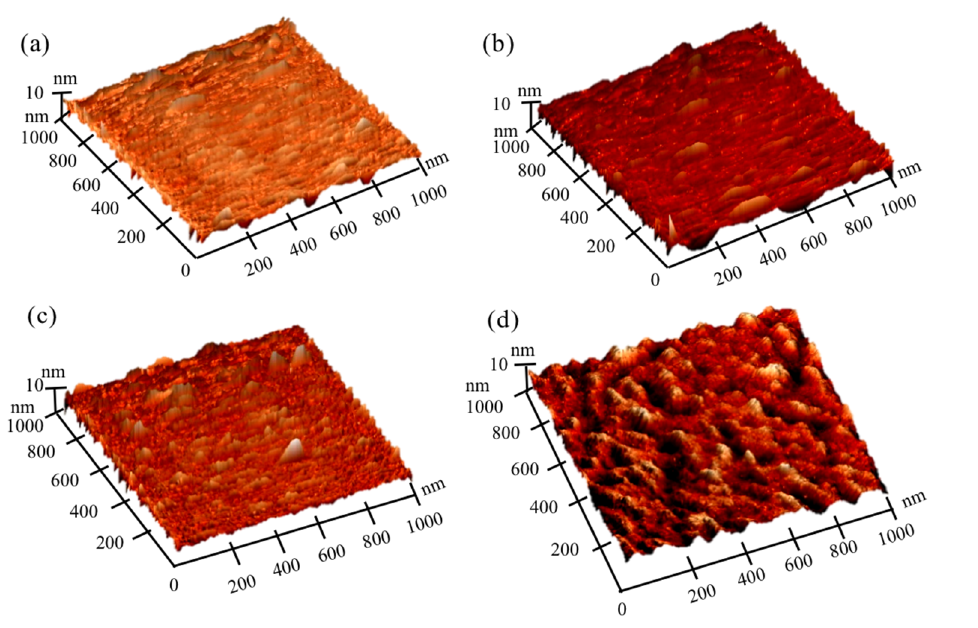
Figure 7. AFM images of ( a ) as-deposited AZO film, ( b ) AZO film that being annealed at 600 °C, ( c ) as-deposited 1.2 at.% Mg-doped AZO film, and ( d ) 1.2 at.% Mg-doped AZO film that being annealed at 600 °C.